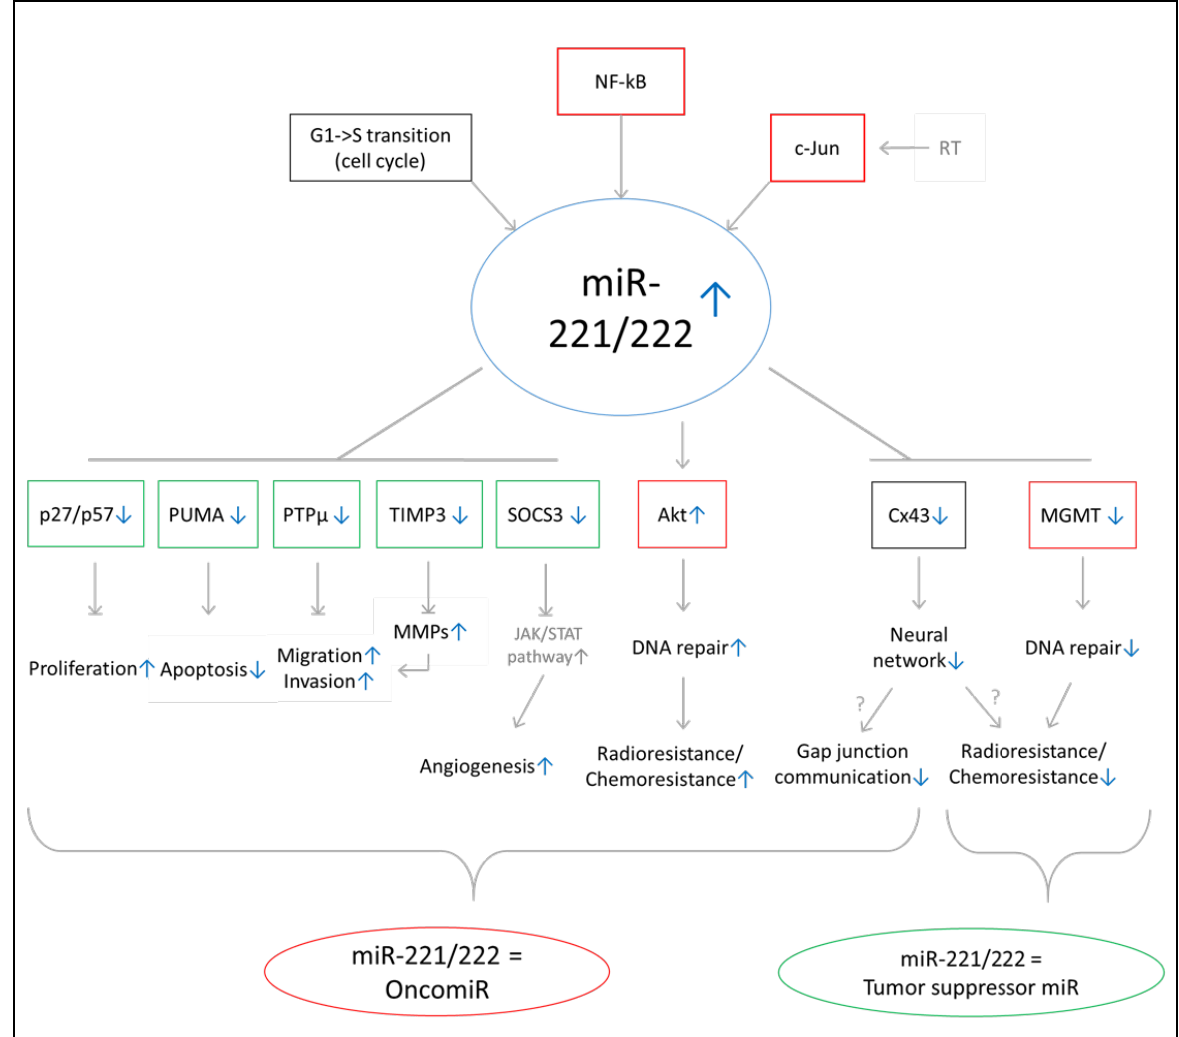
Figure 5. Summary of validated target genes and postulated cellular functions of miR-221/222. Most previous reports have proposed a pro-tumorigenic function of miR-221/222, whereas only a few studies have postulated a tumor-suppressive activity. Candidate target genes of this family and their reported involvement in cellular processes are shown. Green colored framing indicates potential tumor suppressive function of corresponding gene or miR. Red colored framing indicates potential pro tumorigenic function of corresponding gene or miR. Blue arrows indicate direction of regulation for corresponding pathway, miR and gene regulation.